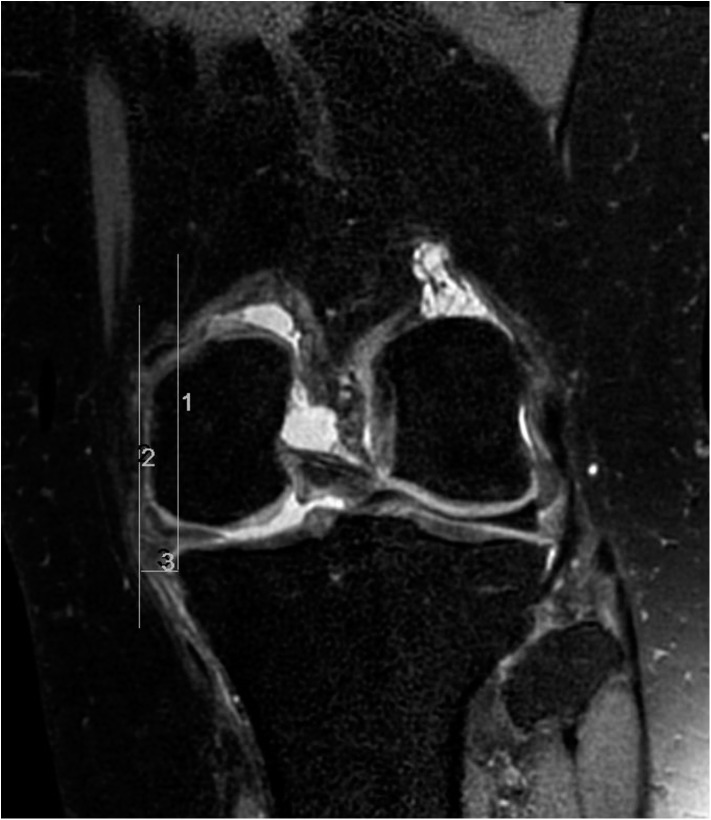
Size measurement of meniscal extrusion.Two vertical lines are drawn in the coronal plane. Line 1 is drawn at the tibial margin, and line 2 is drawn at the end of the extruded meniscus. Between the two vertical lines, the size of the extruded meniscus is measured as line 3.